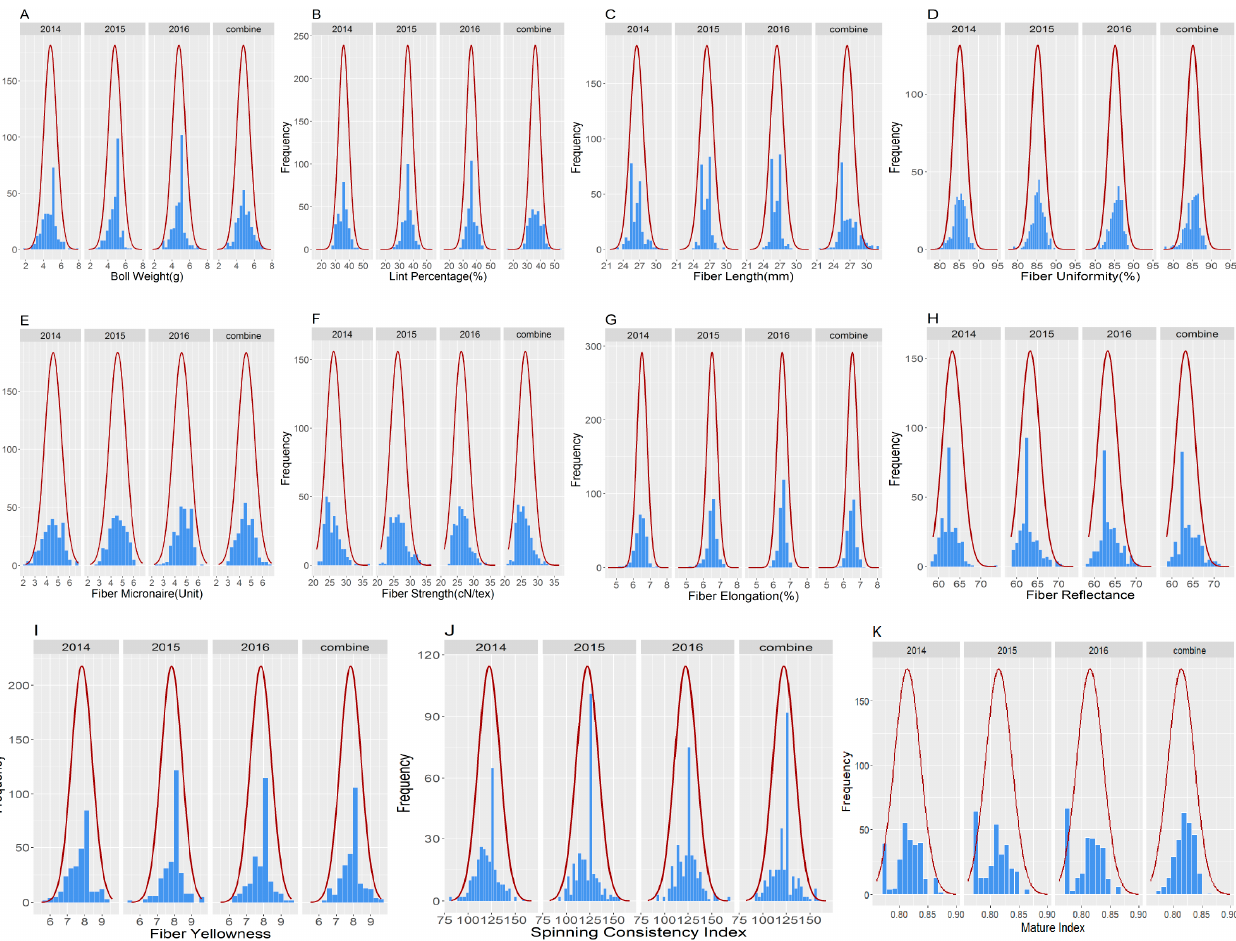
Figure 2. Frequency distribution of the 11 traits for fiber quality traits in F 2:3 , ( A ) Boll Weight (g); ( B ) Lint Percentage (%); ( C ) Fiber Length (mm); ( D ) Fiber Uniformity (%); ( E ) Fiber Micronaire (Unit); ( F ) Fiber Strength (cN/tex); ( G ) Fiber Elongation (%); ( H ) Fiber Reflectance; ( I ) Fiber Yellowness; ( J ) Spinning Consistency Index; ( K ) Mature Index.